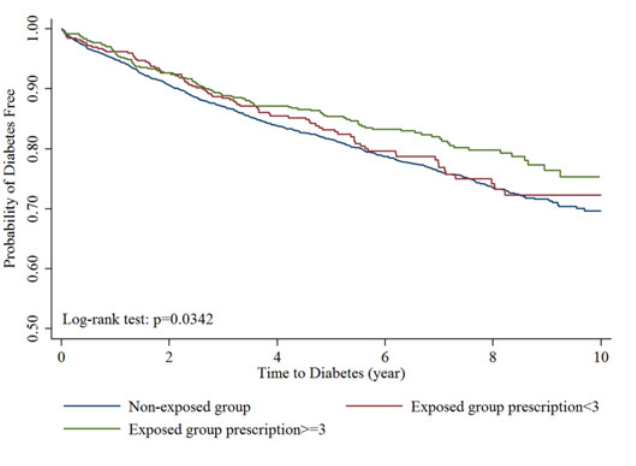
Fig 3. Kaplan-Meier curve of survival to newly diagnosed diabetes mellitus (exposed group classified by prescription times vs non-exposed group).